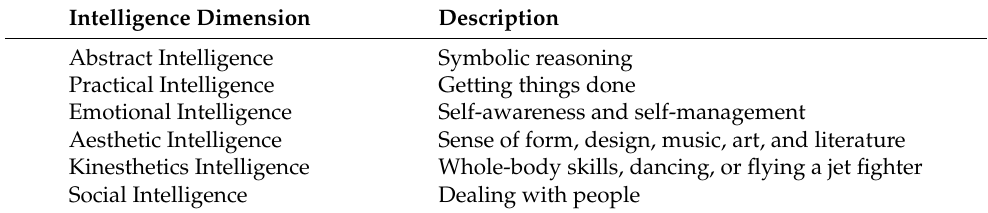
Table 1. Six dimensions of intelligence, according to Albrecht